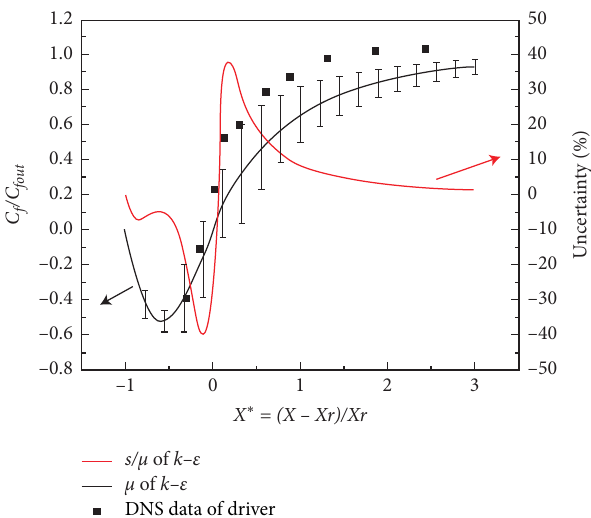
Figure 10: Friction coefficient along the heating wall with 6s uncertainty.